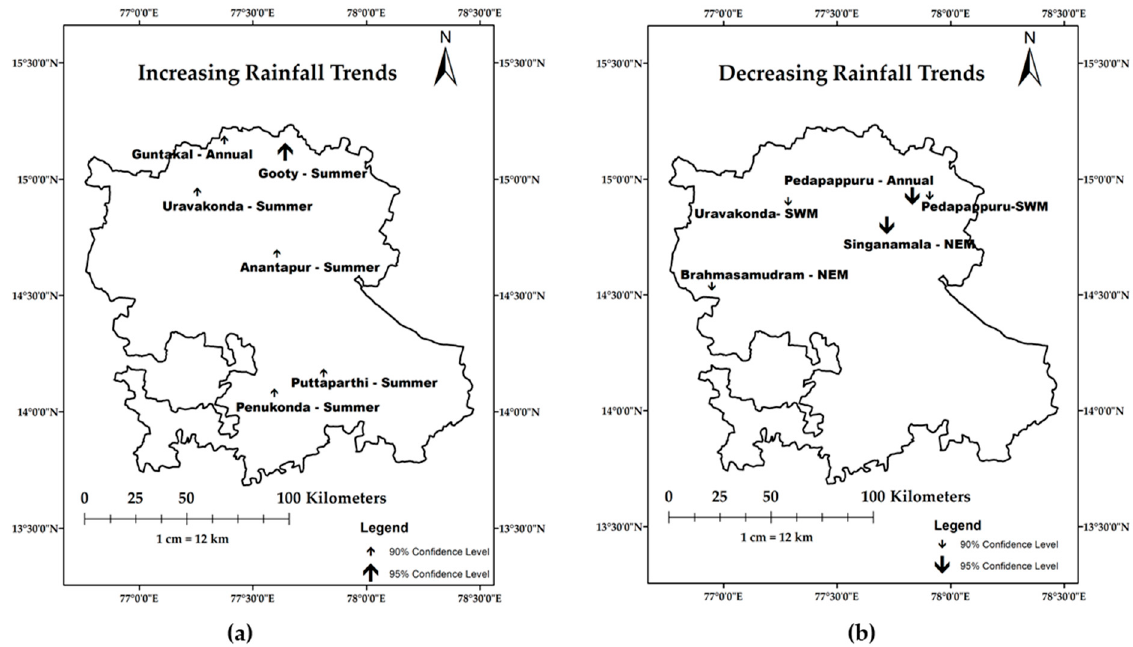
Figure 2. Spatial representation of ( a ) increasing and ( b ) decreasing rainfall series in Anantapuramu.